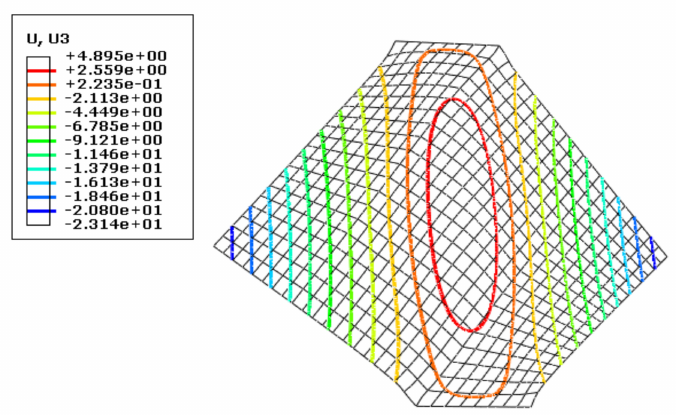
Figure 6. Simulation results for wrinkling of a sheet disturbed by a surface